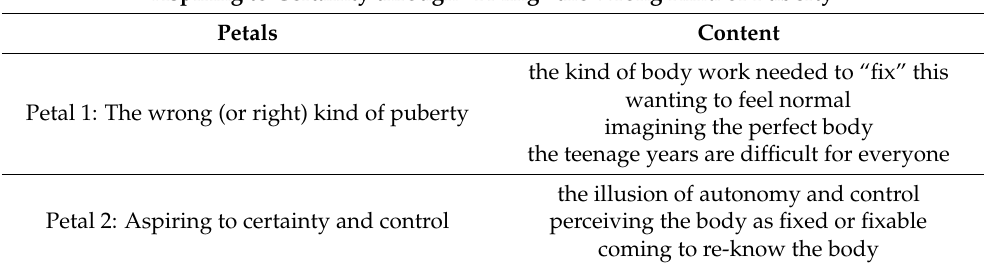
Table 1. Overview of themes and main